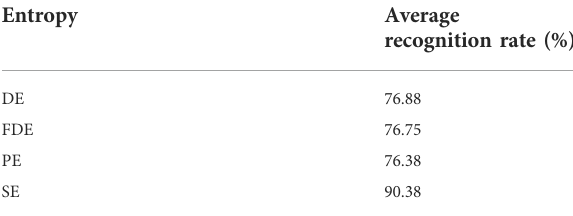
TABLE 2 The highestaveragerecognition rateof fourkinds of entropy under single-feature.